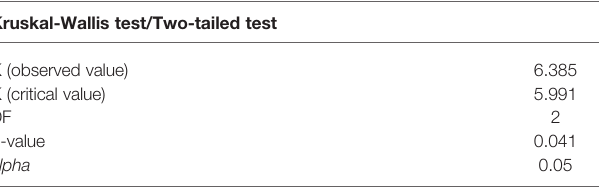
TABLE 3 | Kruskal-Wallis test for the comparison among d 13 C-ETNP SCM, d 13 C-ETSP SCM and d 13 C-ETSP top AMZ (no SCM). K is Kruskal-Wallis test statistic and DF is degrees of freedom.